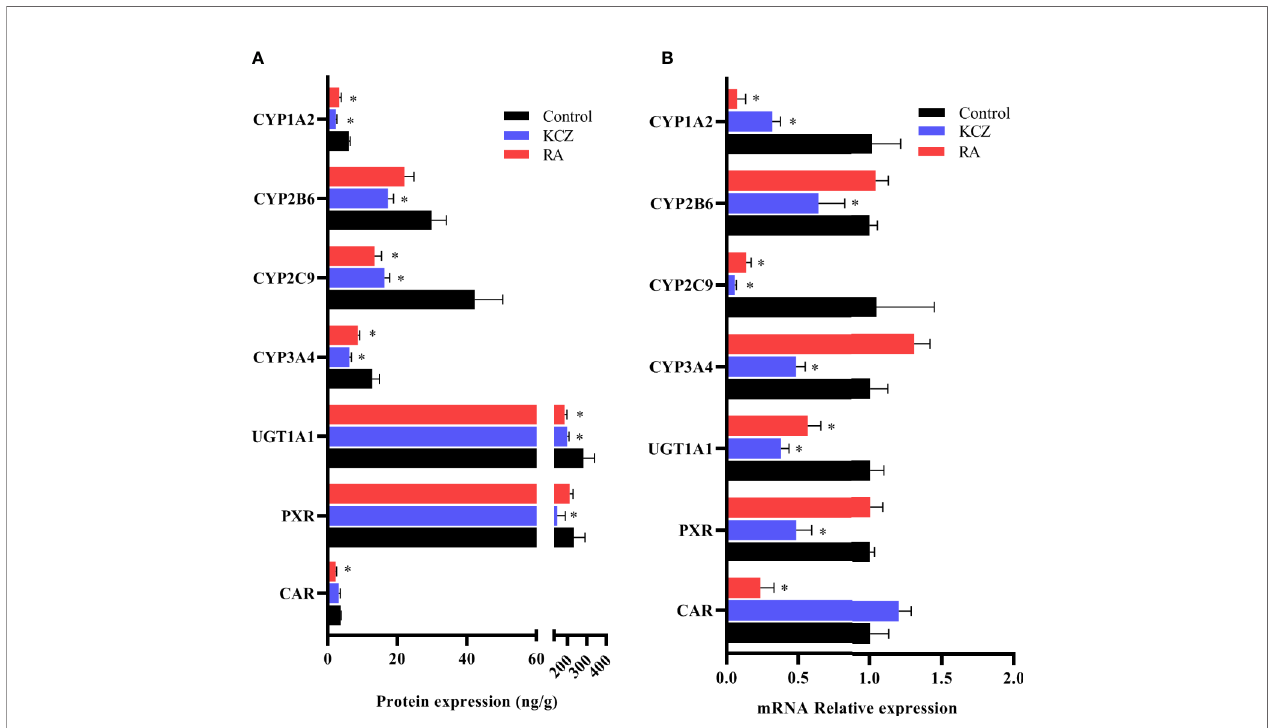
FIGURE 6 | Expression of CYP1A2, CYP2B6, CYP2C9, CYP3A4, UGT1A1, PXR, and CAR in HepG2 cells following treatment with KCZ and RA. (A) The protein expression levels of CYP450 isoforms, UGT1A1, PXR, and CAR. (B) The mRNA expression levels of CYP450 isoforms, UGT1A1, PXR, and CAR. KCZ (Ketoconazole): PXR inhibitors; RA (Retinoic acid): CAR inhibitors. The data were analyzed using a one-way analysis of variance (ANOVA), and the differences between the means of two groups were compared using LSD tests. * indicates the signi fi cance of experimental groups, compared with that of the control. Values were expressed as Mean ± SEM (n = 3). Levels are considered signi fi cant at * p <